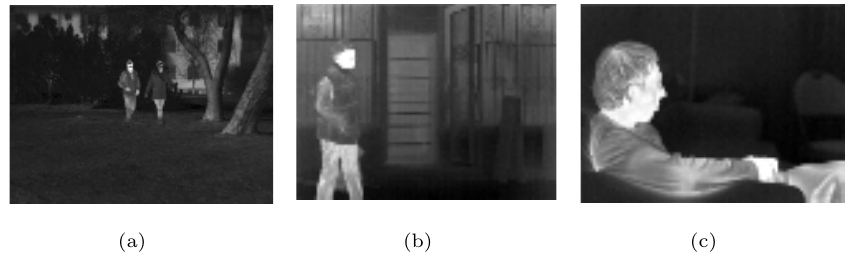
Figure 4. Low-resolution (LR) infrared images down-sampled four-fold without noise: ( a ) birds, 图 1: description of figure ( b ) passerby, ( c ) figure.